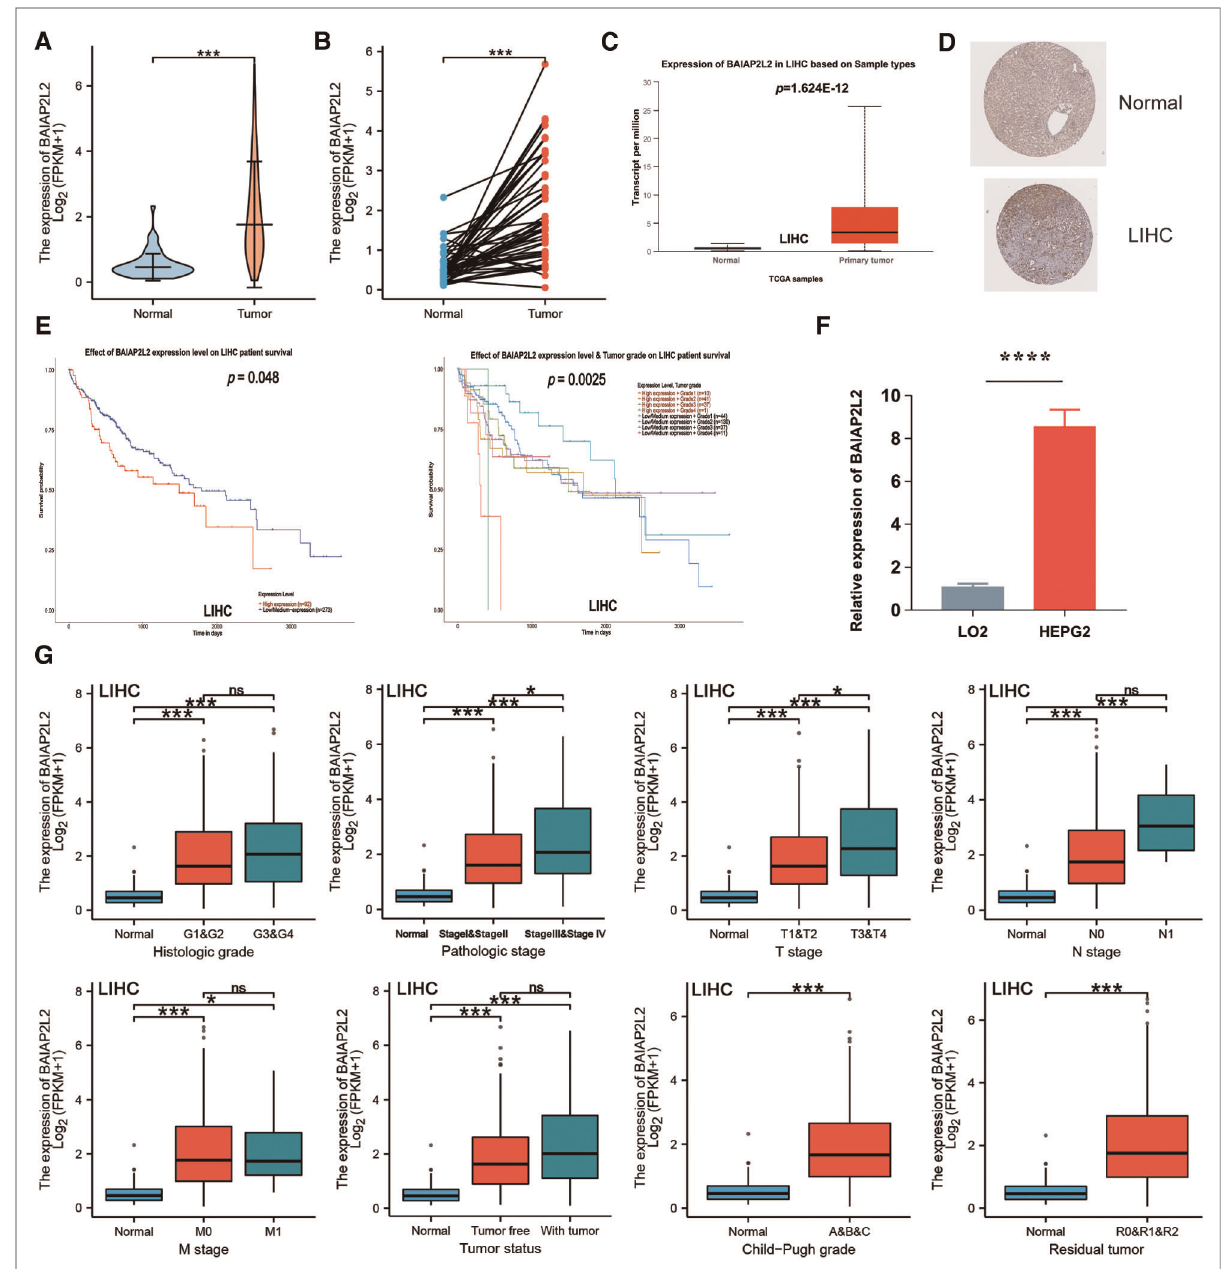
FIGURE 5 Validation of the expression level of BAIAP2L2 and high BAIAP2L2 expression is correlated with clinical characteristics in patients with LIHC. ( A ) The differential expression of BAIAP2L2 in LIHC samples and unpaired adjacent samples from TCGA. ( B ) The differential expression of BAIAP2L2 in 50 LIHC samples and matched adjacent samples from TCGA. ( C ) Validation of BAIAP2L2 at the mRNA level using the UALCAN database. ( D ) Validation of BAIAP2L2 at the protein level using the HPA database. ( E ) Survival analyses of BAIAP2L2 expression in LIHC. ( F ) Validation of BAIAP2L2 at the mRNA level in vitro using qRT – PCR analysis. Relative BAIAP2L2 mRNA levels in a LIHC cell line (HEPG2) and a human Normal liver cell line (LO2). ( G ) Box plot assessing BAIAP2L2 expression in patients with LIHC according to different clinical characteristics using the UALCAN database. * p <0.05, ** p <0.01, *** p <0.001, **** p